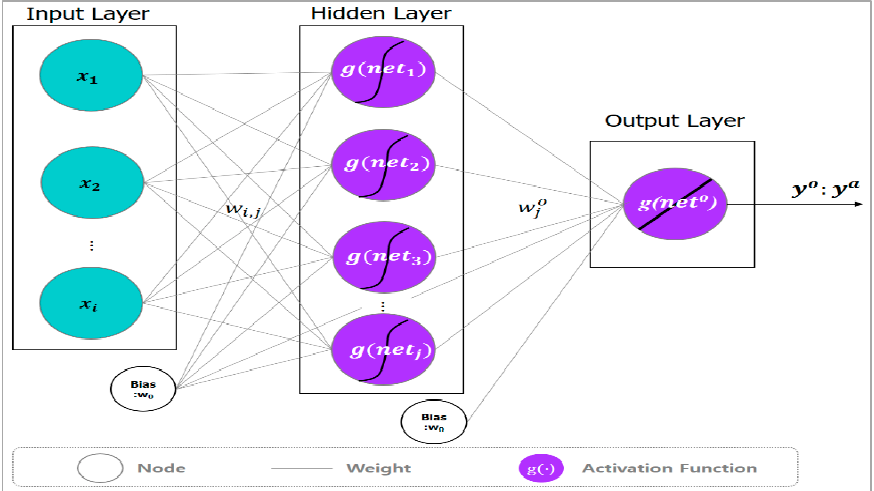
Figure 3. Structure of artificial neural networks.